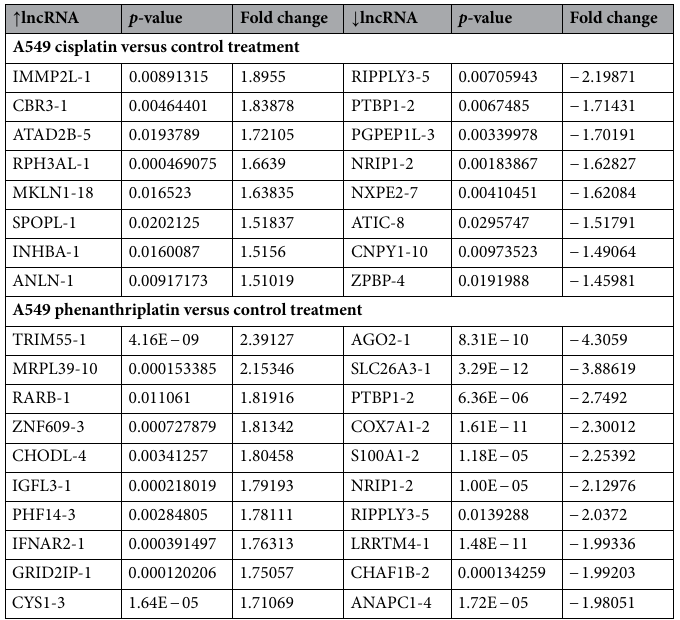
Table 1. Top up- and downregulated lncRNAs in cisplatin or phenanthriplatin treated A549 cells versus control (N = 4; p ≤ 0.05; fold change ≥ 1.5).